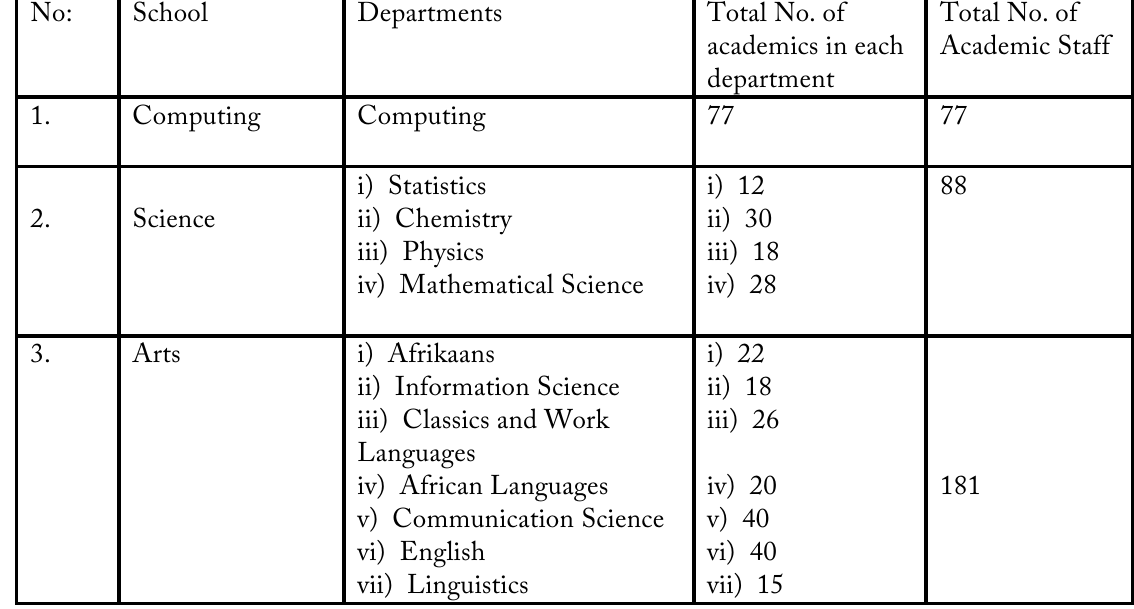
Table 1: Distribution of departments and academics in the Schools of Computing, Science and Arts at UNISA (Source: UNISA HRIS, March